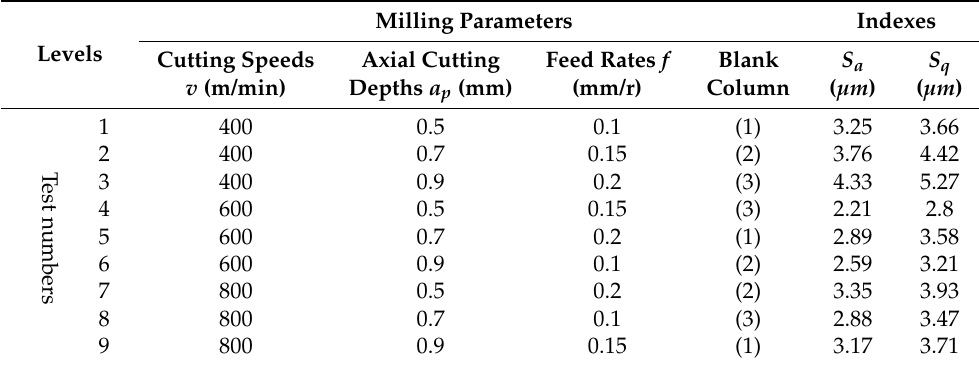
Table 4. Experimental designs and results of orthogonal milling.